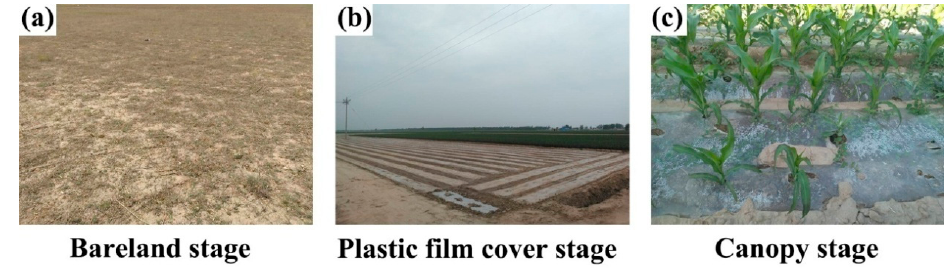
Figure 2. Three stages of plastic-mulched land (PML) during the growing season.